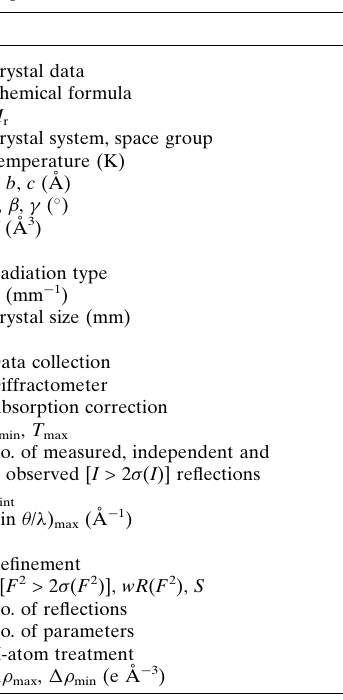
Table 1 Experimental details.